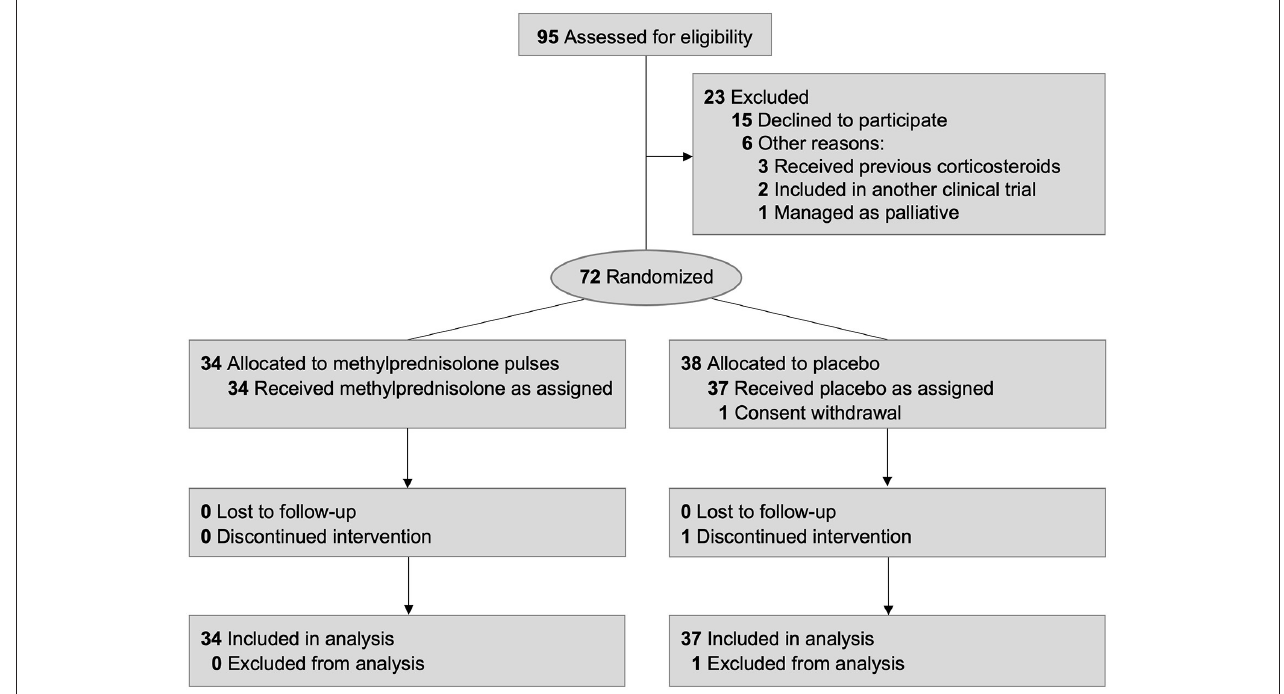
FIGURE 1 | Participant flow